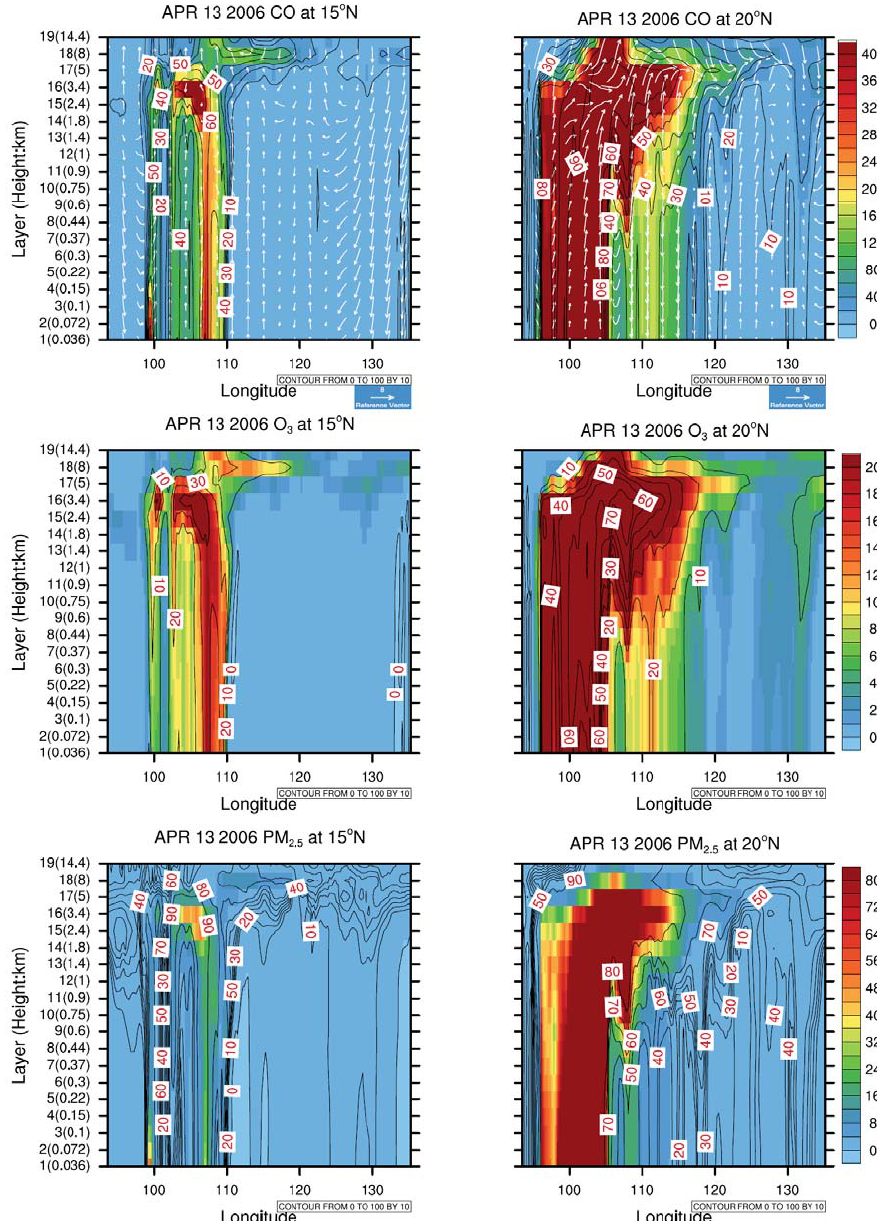
Figure 10. Similar as Figure 7 but for the episode on April 13, 2006. Fig. 10. Similar as Fig. 7 but for the episode on 13 April